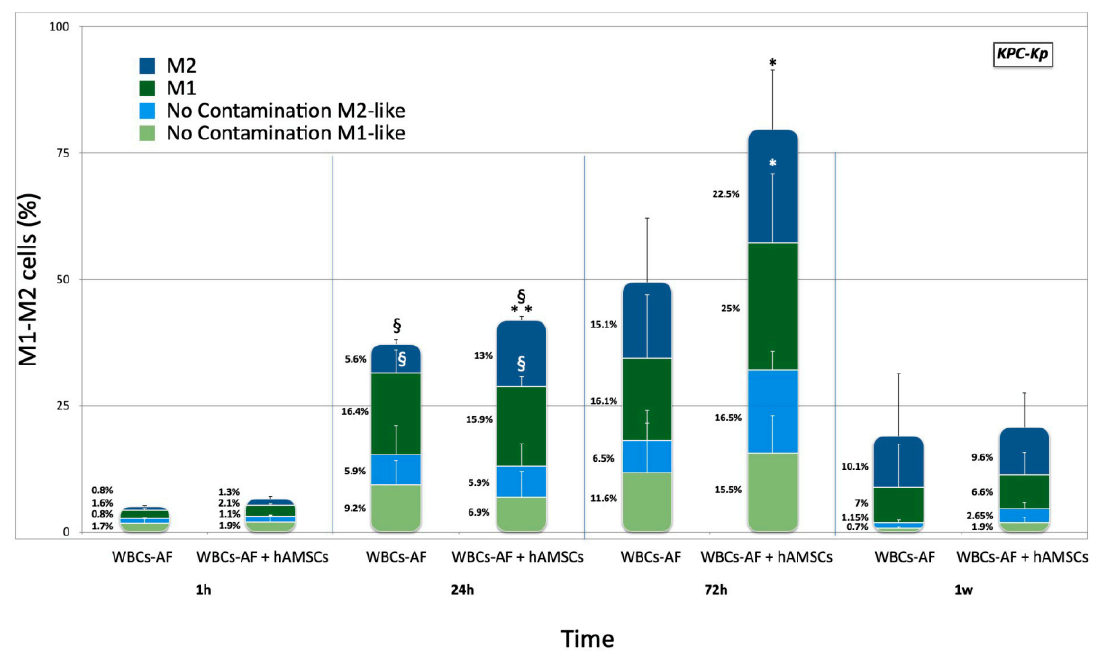
Figure 3. M1 and M2 phenotypes expressed by WBCs derived from the ascites of cirrhotic patients infected with KPC-Kp after co-culture, with and without hA-MSCs, for the time points chosen (1 h, 24 h, 72 h, and 1 week) compared to the M1 and M2 phenotypes expressed by WBCs cultured without KPC-Kp . The graph shows that there were no significant differences in the expression of the M1 and M2 components in samples not infected with KPC-Kp , regardless of the presence of hA-MSCs in culture. However, in the presence of bacteria, at 24 h of co-culture, a significant increase of both M1- and M2-like cells was observed compared to 1 h ( p < 0.05, §), both in the presence of hA-MSCs and in Control 2, while a boosted reaction of the M2 component occurred in the presence of hA-MSCs compared to Control 2 at the same time-point ( p < 0.01, **). At 72 h, an increase in the M1 and